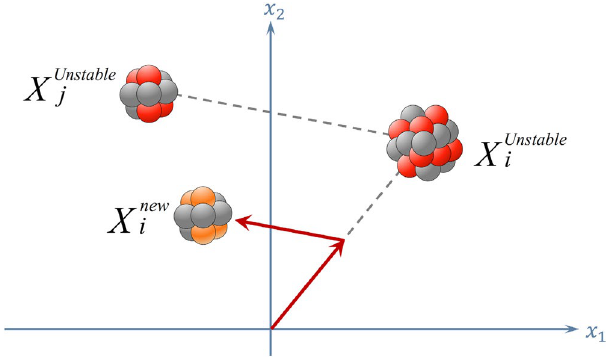
Figure 8. Fission of two unstable nuclei.